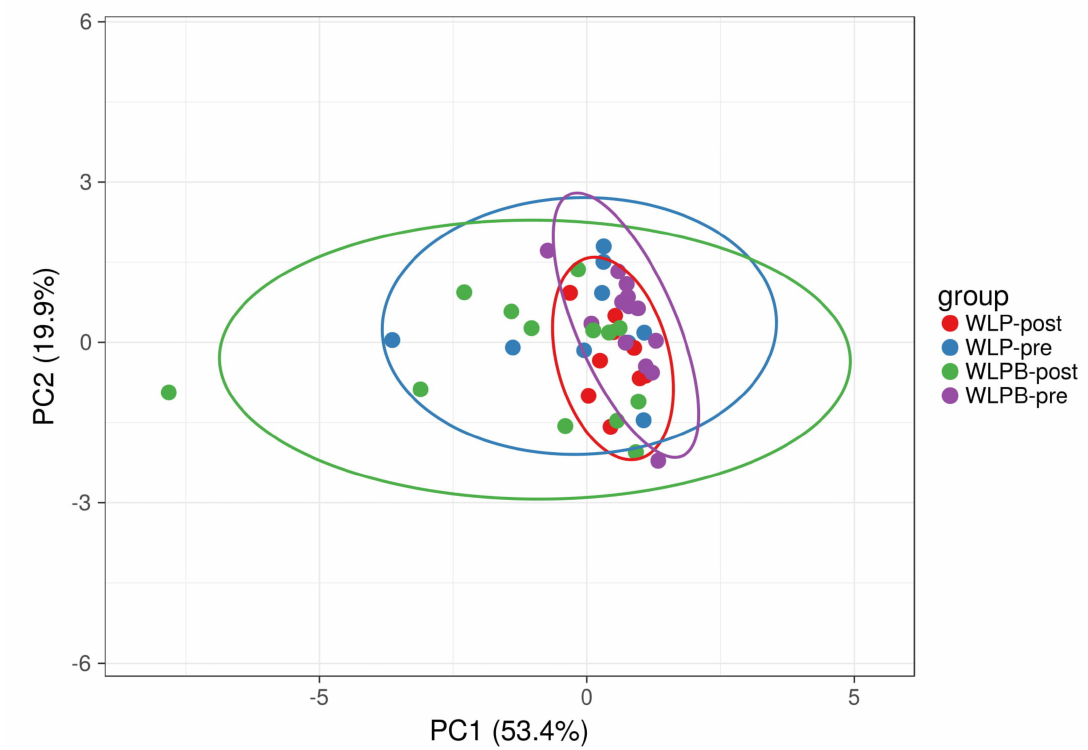
Figure 2. Beta diversity of analysed samples represented by significantly altered ( p < 0.05) bacterial taxa, selected by a Random Forest machine learning analysis, before and after a short-term weight loss program in Bryndza and control groups visualised by PCA. SVD with imputation is used to calculate principal components. The X and Y axis show principal component 1 and principal component 2 that explain 53.4% and 19.9% of the total variance, respectively. Prediction ellipses are such that with a probability of 0.95, a new observation from the same group will fall inside the ellipse ( n = 44 data